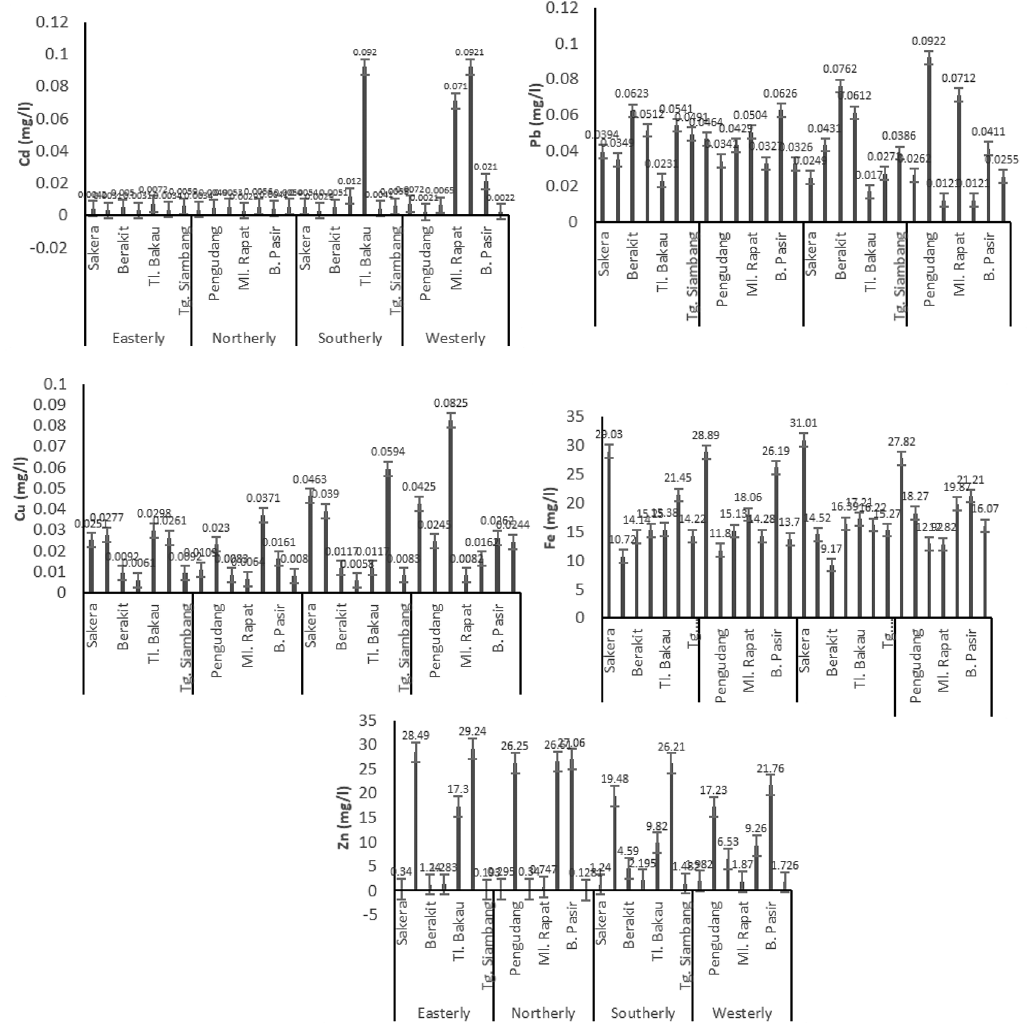
Figure 5. Average concentration of heavy metal (µg/g) of Cd, Pb, Cu, Fe, and Zn in the sediment during Northerly-Westerly monsoon in Bintan Island coastal